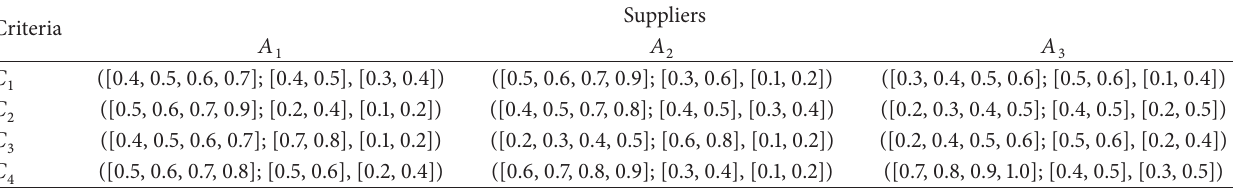
Table 3: Assessment by DM 3 .